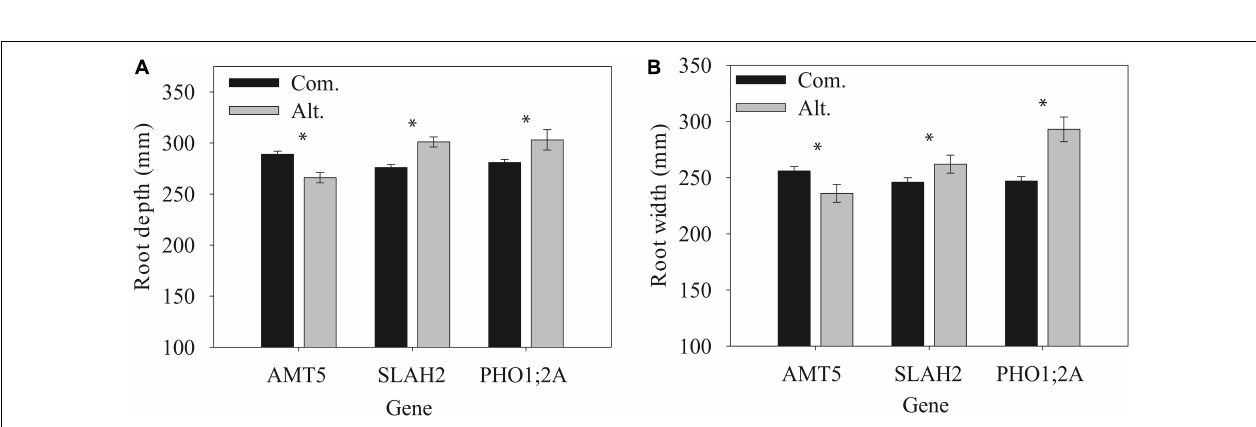
FIGURE 10 | RSA traits of nutrient channel candidate genes, root system depth (A) and width (B) . Data are mean ± SE for the common (Com) and alternate (Alt) alleles under full irrigation post-flowering. ∗ Indicates a significant difference between alleles, P < 0.05.